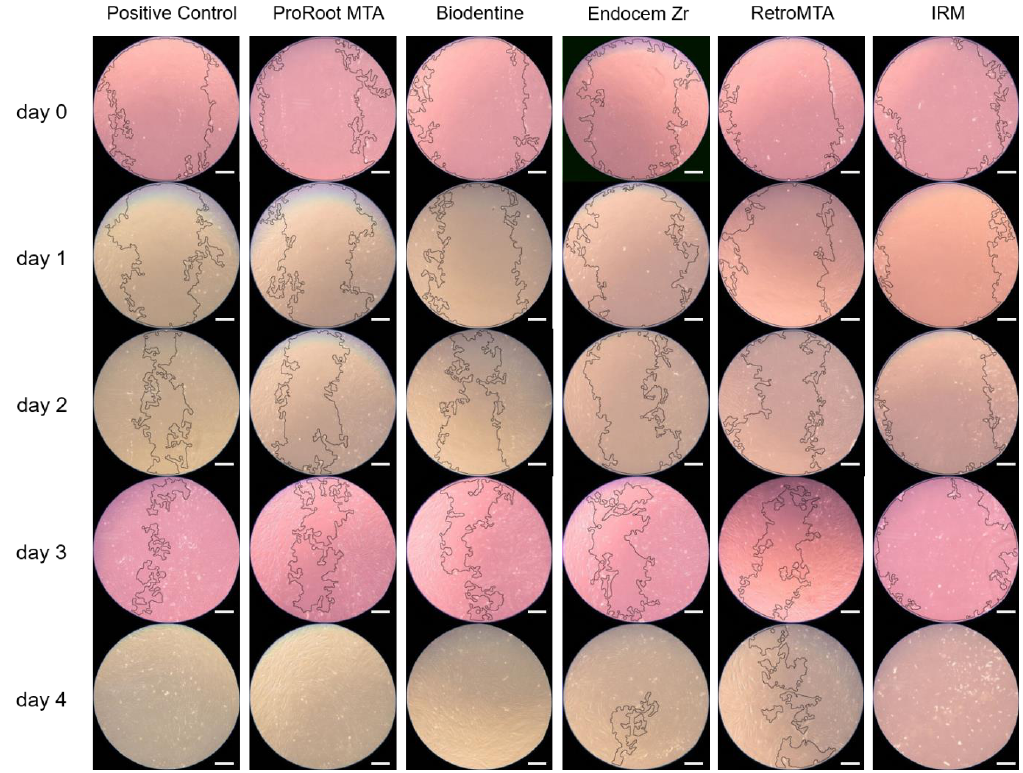
Figure 3. Representative images of cell migration based on wound healing assay (scale bar = 250 μm). In the live/dead staining assay, GDSCs in contact with IRM extract showed low viable cell density, whereas GDSCs in contact with the other experimental cements showed favorable cell growth relative to the control group (Figure 4).